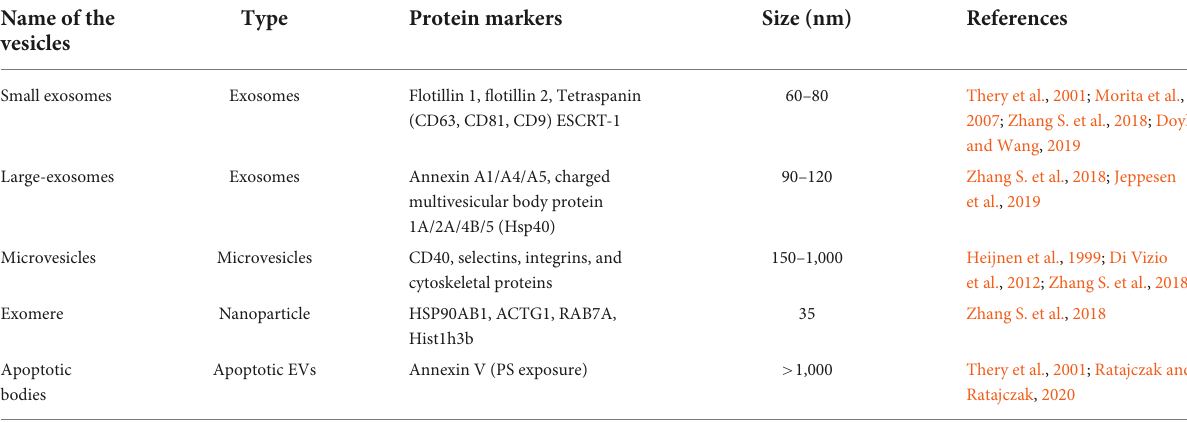
TABLE 1 Classification of Extracellular vesicles and their